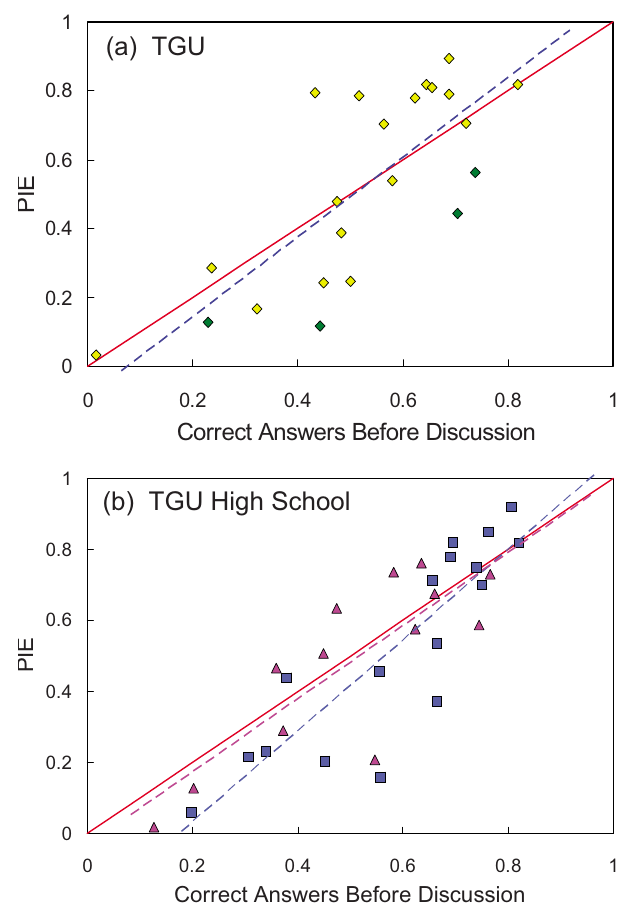
FIG. 2. (cid:1) Color (cid:2) The peer instruction efficiency (cid:1) PIE (cid:2) versus cor- rect answers before discussion for (cid:1) a (cid:2) the university course and (cid:1) b (cid:2) the high-school courses. The red solid lines represent the theoretical line of Eq. (cid:1) 9 (cid:2) . The broken lines represent the best fitting lines for the data. In (cid:1) b (cid:2) the violet (cid:1) blue (cid:2) points and line represent the 2008 (cid:1) 2009 (cid:2) data. The four green points in (cid:1) a (cid:2) represent data associated with Newton’s third In Fig. 2 we compare theoretical line of PIE (cid:3) Eq. (cid:1) 9 (cid:2)(cid:4) with served. As seen from Eq. (cid:1) 7 (cid:2) , PIE is equivalent to T¯ (cid:1) q (cid:2) .